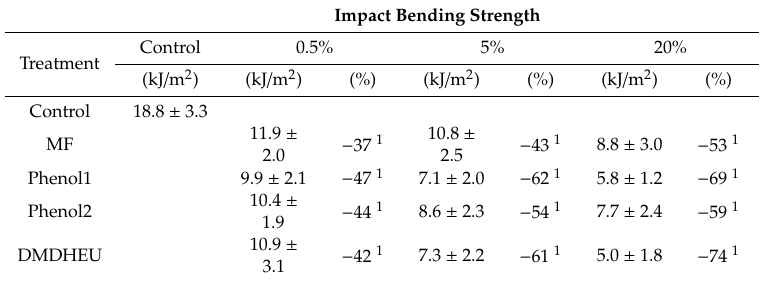
Table 5. Impact bending strength (kJ/m²) and change compared to control (%) depending on the modification agent and the concentration (mean ± SD)